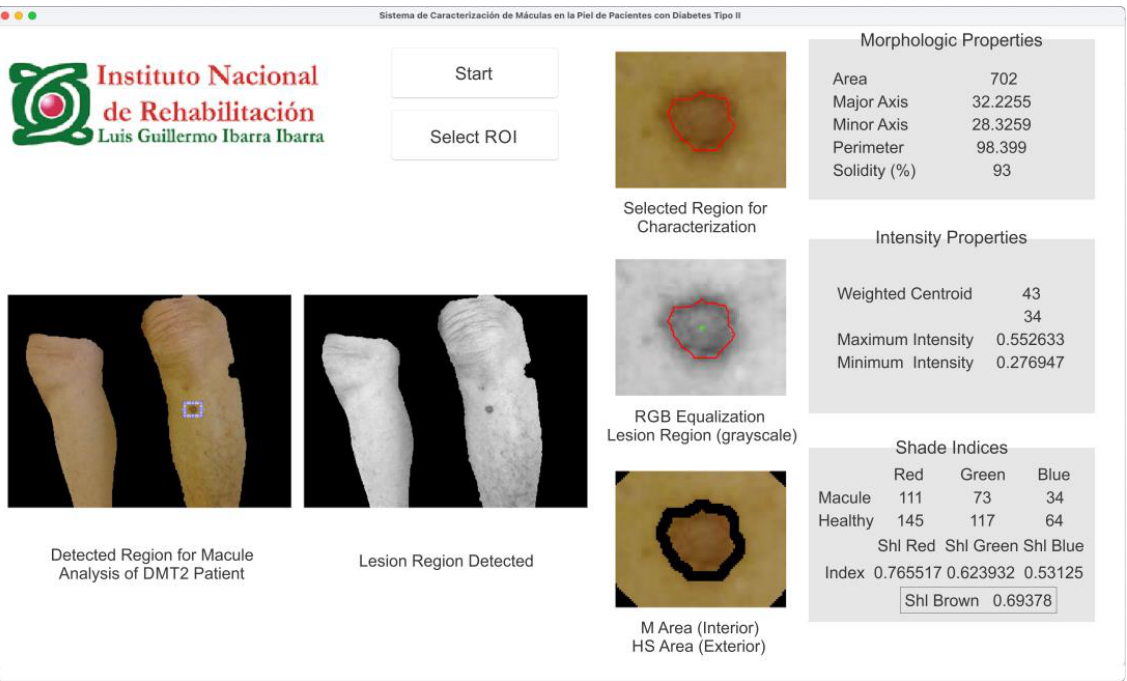
Figure 8. SMaC© software for segmentation and characterization of macules in diabetic patients. The macule shown is due to trauma.